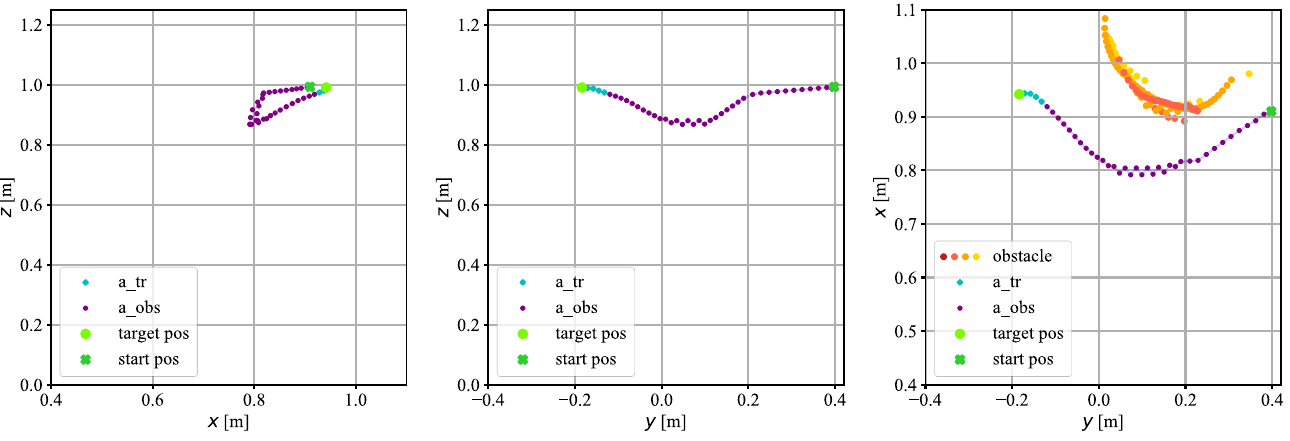
Figure 14. The trajectory on which the TCP of the robot moved in experimental research. A cylindrical obstacle. Position of the obstacle 𝑦 > 0 m.